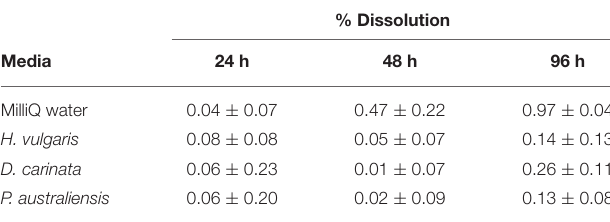
TABLE 2 | Influence of exposure time on percentage of soluble Ag + released from tyr-AgNPs.